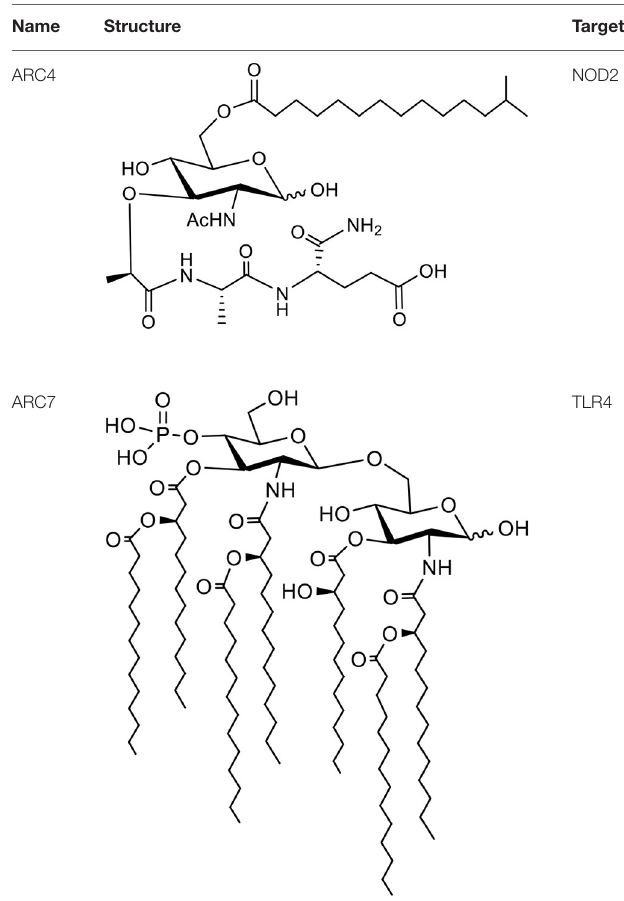
TABLE 1 | Schematic of ARC4 and ARC7 and